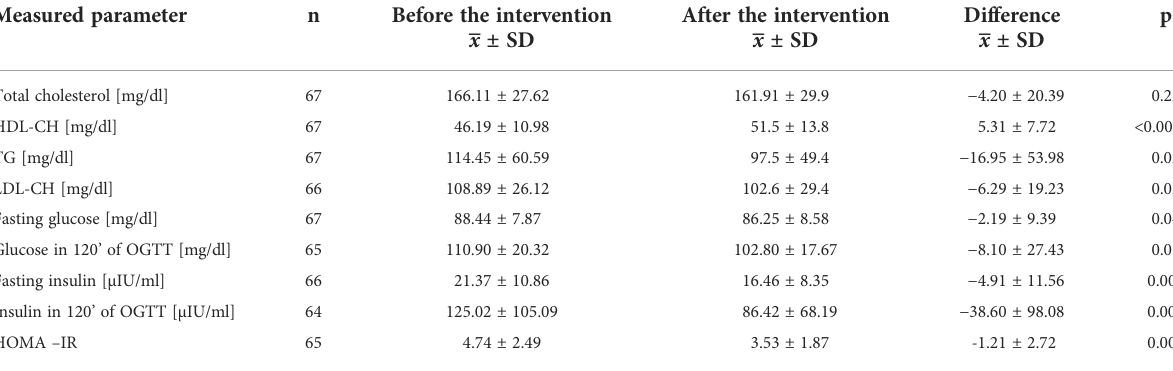
TABLE 2 Changes in lipid and glucose metabolism parameters before and after the dietary intervention. Measured parameter